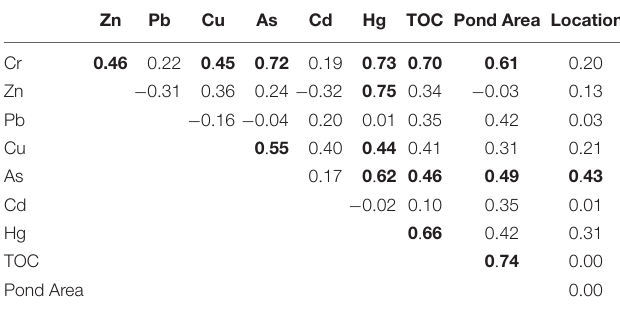
TABLE 2 | Spearman correlation between environmental